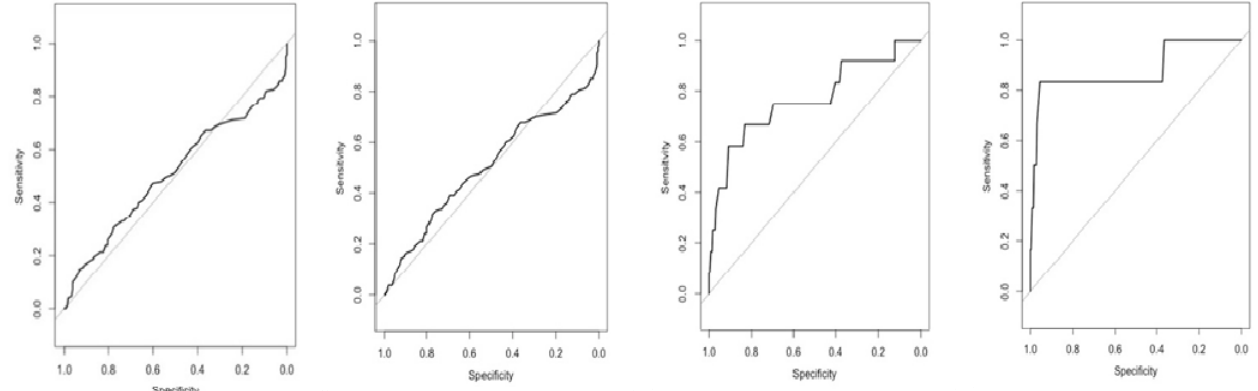
Figure 5. ROC curve of PGI/PGII ratio. From left to right, AUC curve analysis of PGI/PGII ratio for chronic gastritis, mild atrophy, moderate atrophy, and metaplasia. The highest AUC was 0.8804 to discriminate the presence of metaplasia.